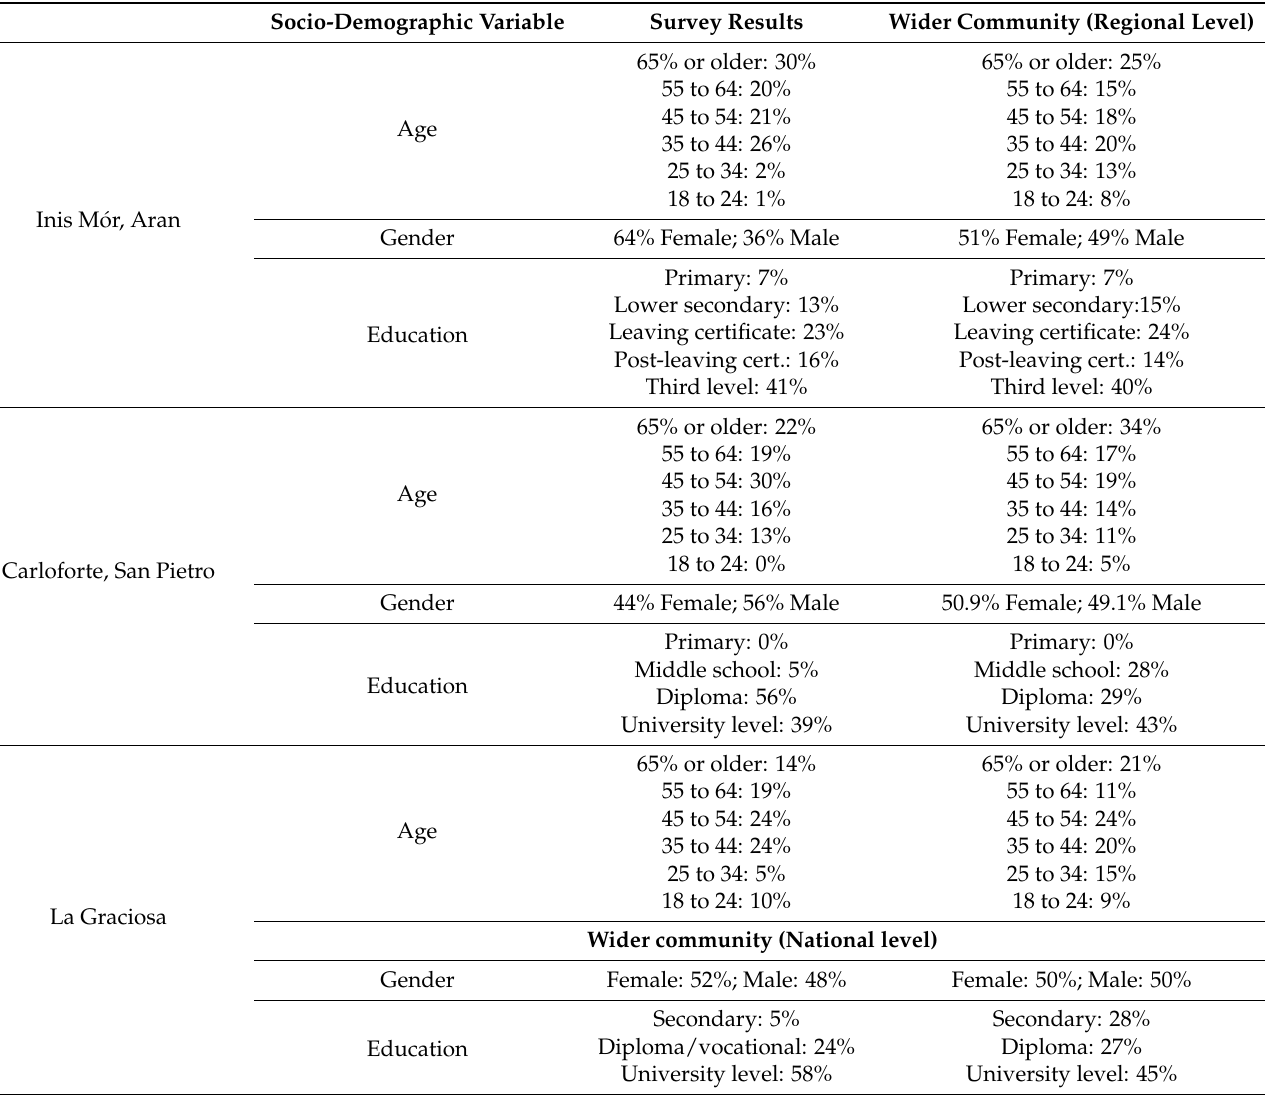
Table 1. Comparison of survey demographic data with wider community regional and national demographic data in the three islands. Socio-Demographic Variable Survey Results Wider Community (Regional